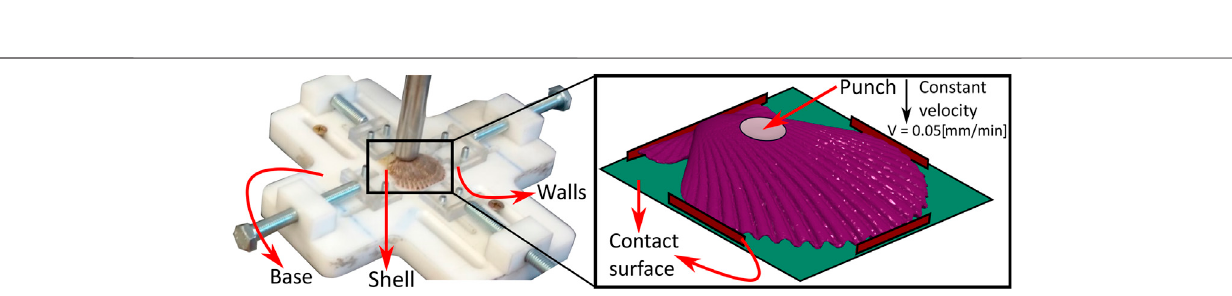
FIGURE 1 | Speci fi cation for grips and samples for the tensile tests: (A) shows the sample design for the tensile test, the principal ’ s directions, and orientations of the samples. (B) shows the cross-sectional area of the samples and how it is estimated. (C) shows the tensile test assembly. All dimensions are shown in mm.